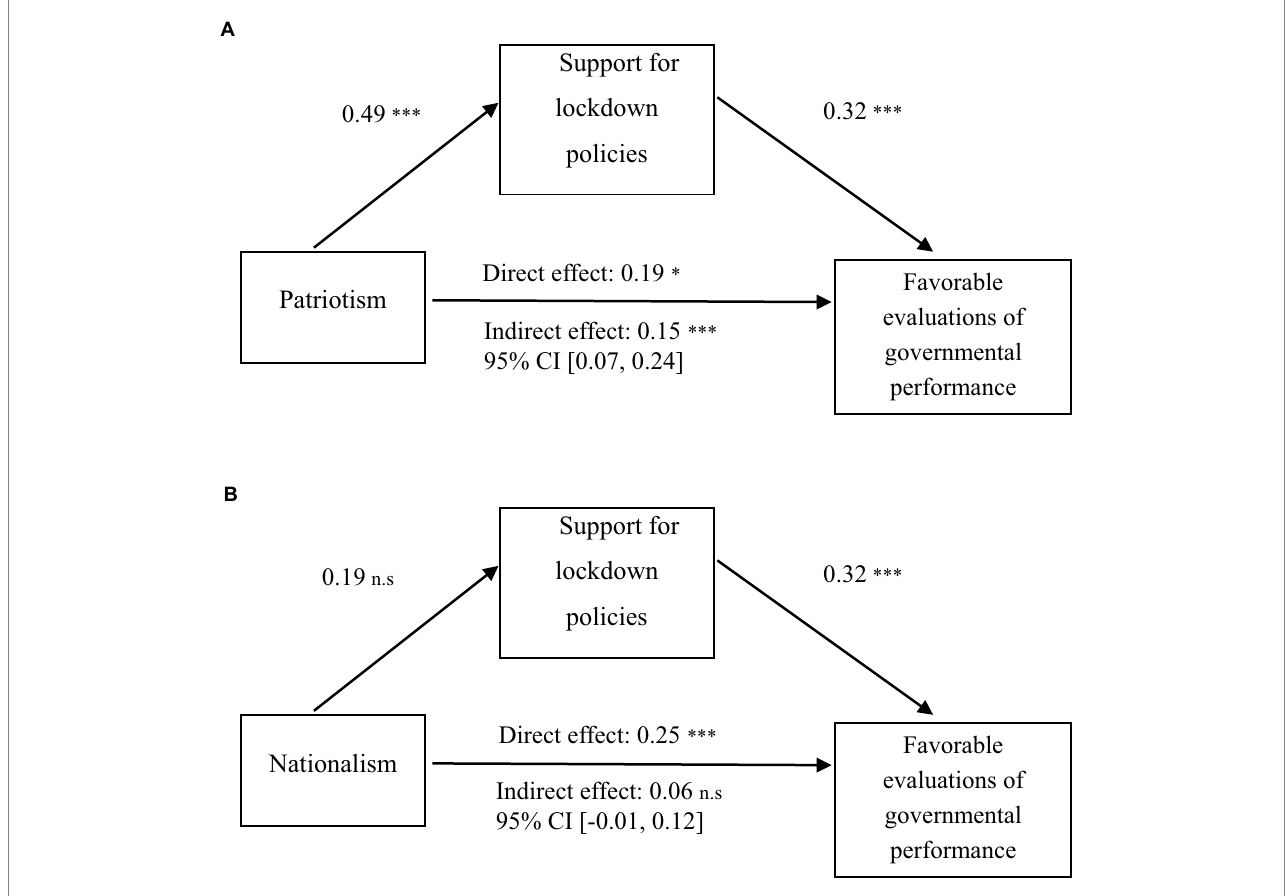
FIGURE 1 Path model of the effects of patriotism and nationalism on favorable evaluations of government performance, * p < 0.05, *** p <